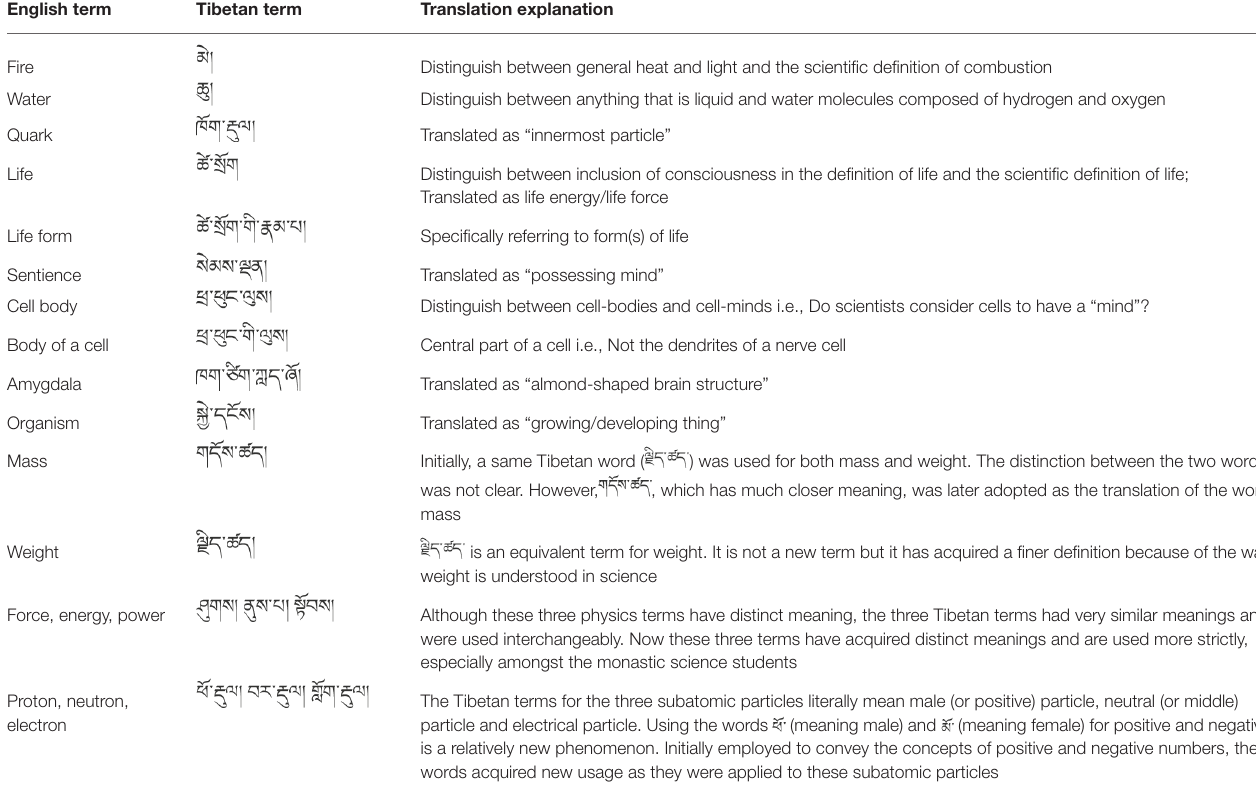
TABLE 1 | Example scientific terms and how these were translated into Tibetan